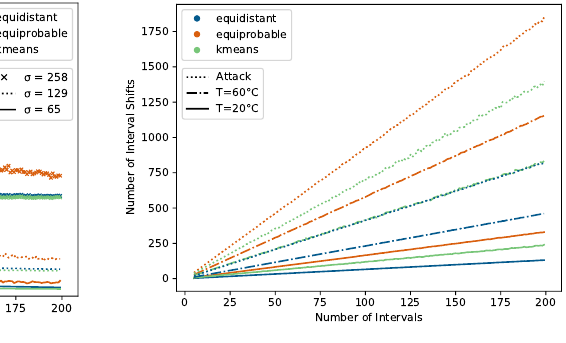
(b) Number of interval shifts in a PUF-response (a) Distortion for equidistant (blue), equiprob- at T = 20°, T = 60°, and drilling attacks able (red), and k-means (green) quantization for equidistant (blue), equiprobable (red), and with three different noise distributions, σ n = 65, kmeans (green) quantization. σ n = 129, and σ n = 258 for 5 to 200 intervals. Figure 8: Distortion (a) and number of changed intervals (b) for equidistant (blue), equiprobable (red), and kmeans (green)